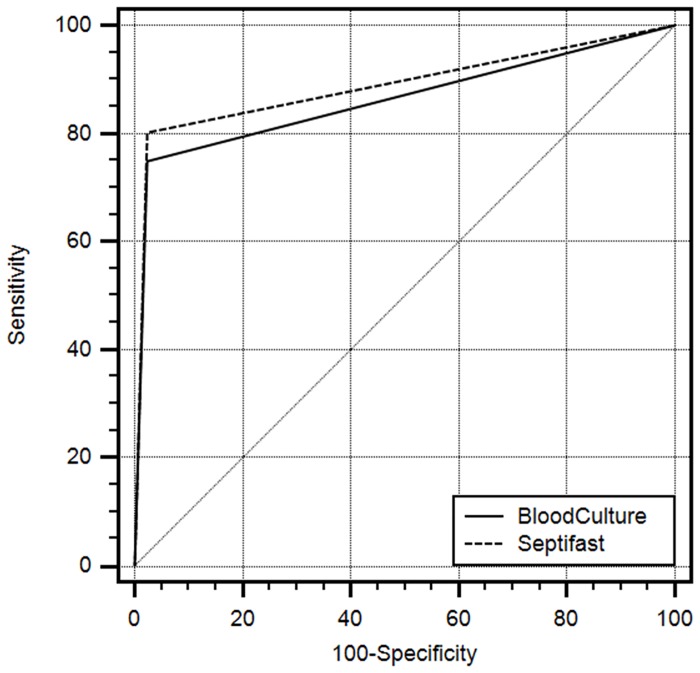
ROC-AUC curves of blood culture (BC) and SF analysis.BC: 0.863ROC-AUC (CI: 0.810–0.905), SF: 0.890 ROC-AUC (CI: 0.841–0.928); the difference between both ROC-AUCs was not found to be statistically significant (p = 0.558 DeLong test).